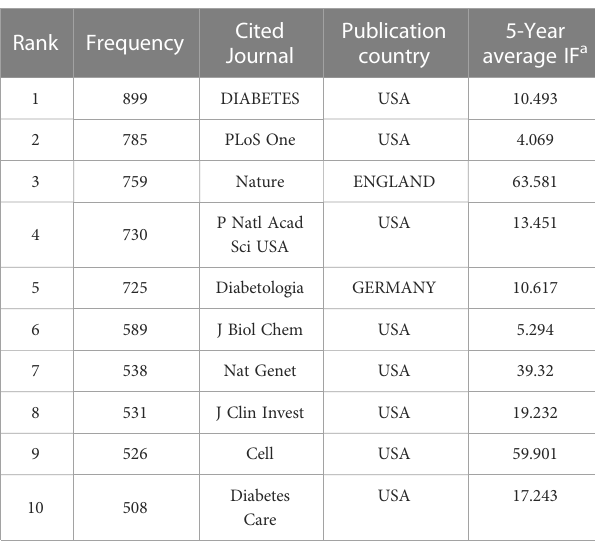
TABLE 3 Top 10 cited journals that have published the most works related toT2DM and DNA/RNA methylation modi fi cations.